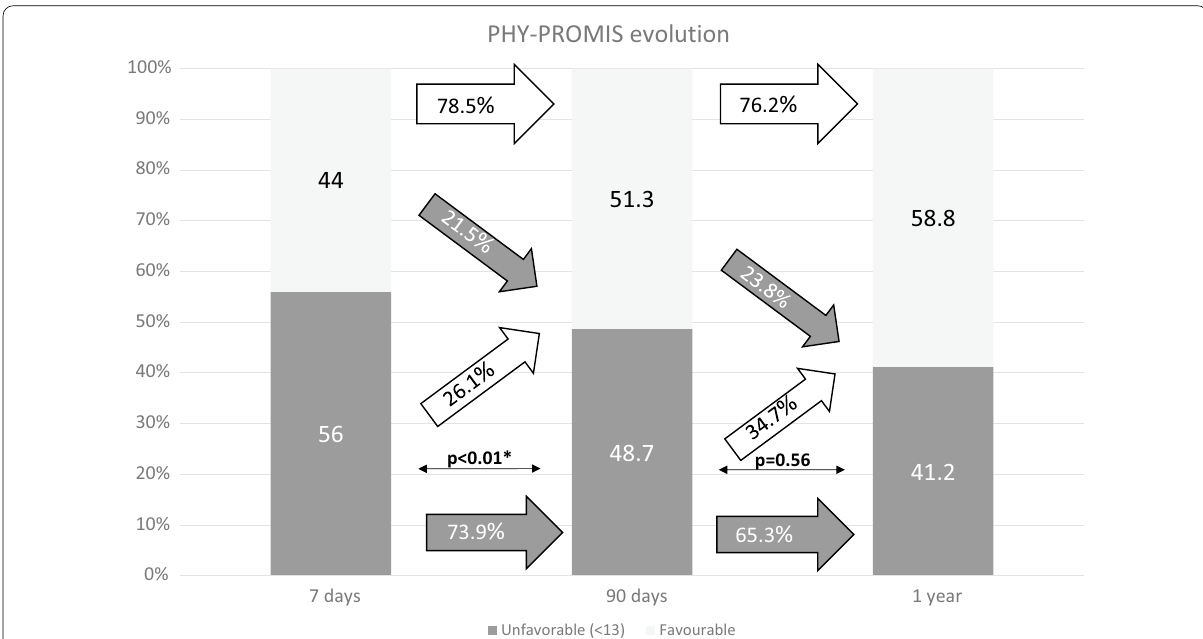
Fig. 2 Rate of favorable and unfavorable results in the physical sub‑score of PROMIS‑10 scale (PHY‑PROMIS) at different time‑points along follow‑up: 7 days, 90 days and one year after stroke. The white arrows represent the rate of patients with improvement in the measured PROM or persistence of favorable outcome at the following time‑point of evaluation. The gray arrows represent impairment toward an unfavorable result in the measured PROM or unfavorable outcome persistence. Thin arrows represent statistical comparison of the rate of favorable/unfavorable outcomes as compared with the previous time‑point. *Statistically